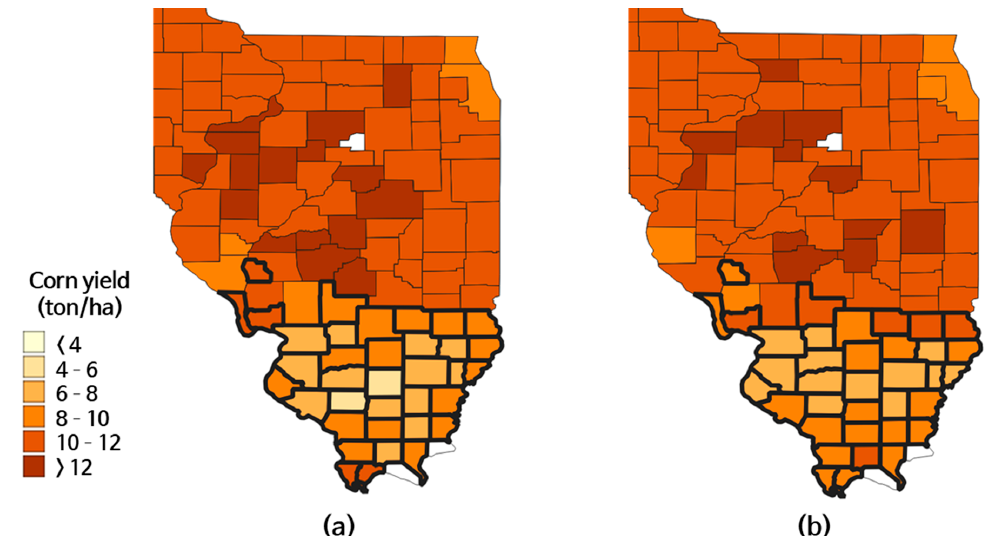
Figure 10. Maps of ( a ) actual and ( b ) predicted corn yields from the leave-one-year-out blind tests for